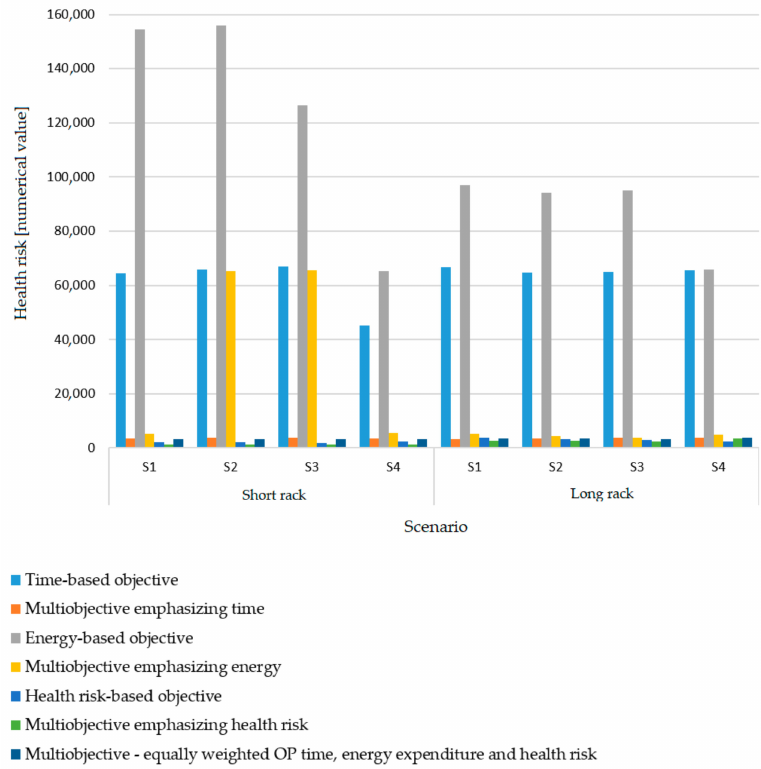
Figure 11. Comparisons of health risk values from different objective